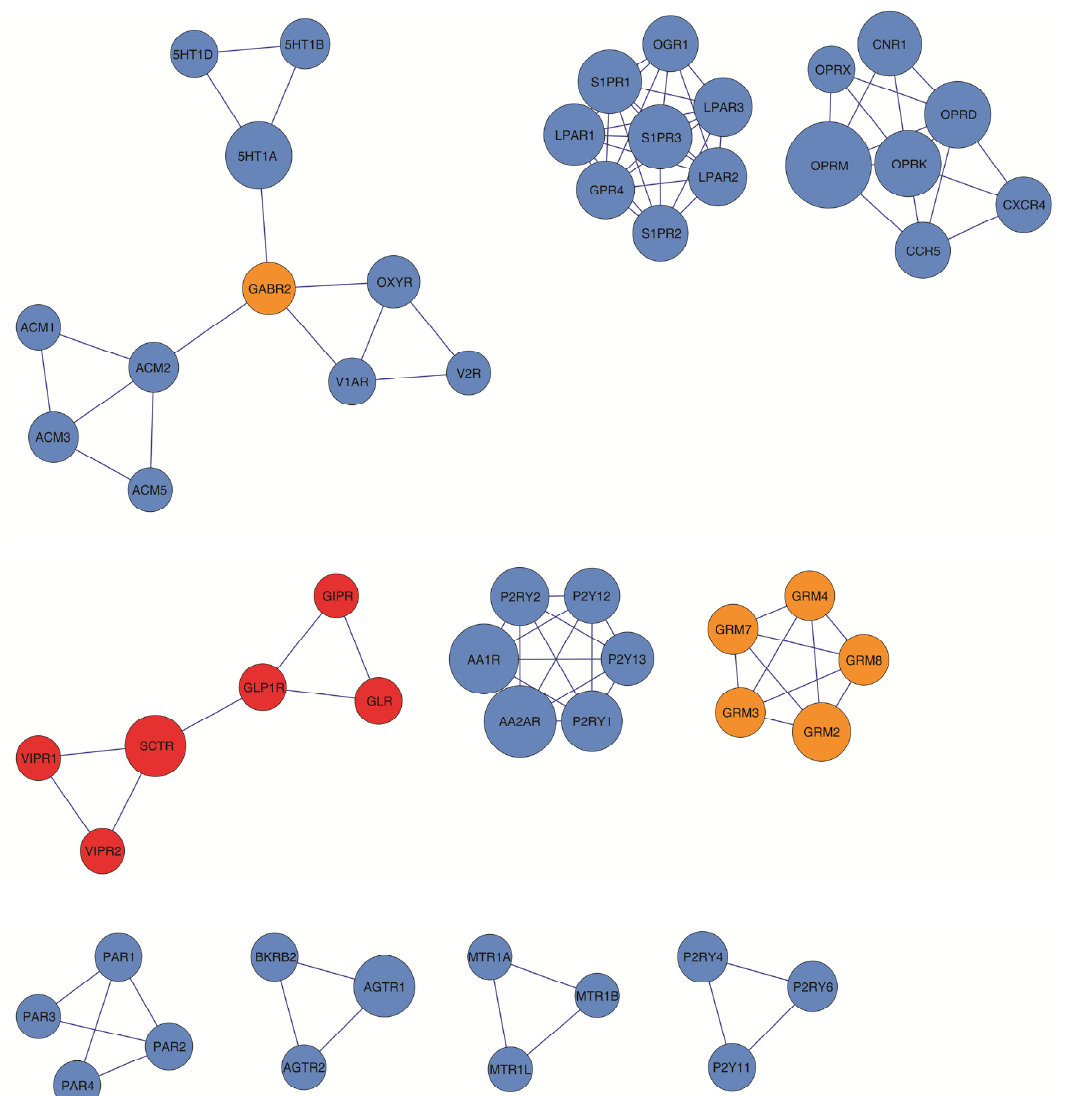
Figure 4. GPCR-HetNet motifs. Nine clusters identified using the MCODE search algorithms are represented and rank ordered, from top left to right down, according to their density (inter-connectivity) and size (number of